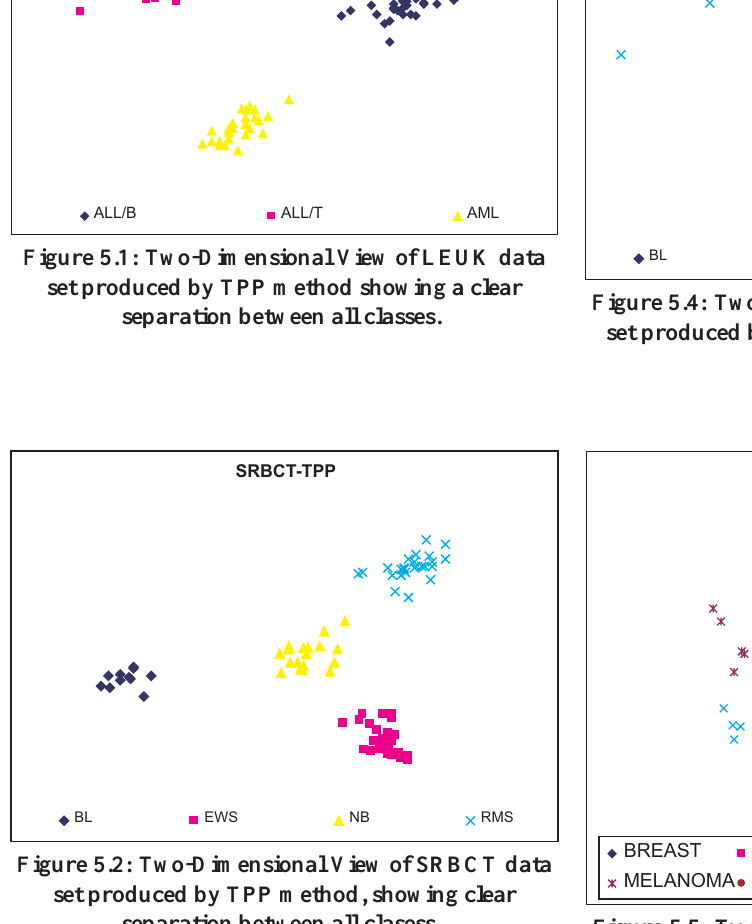
Figure 5.5: Two-Dimensional View of NCI data set produced by TPP method: most classes are clearly seperated, albeit with outliers.